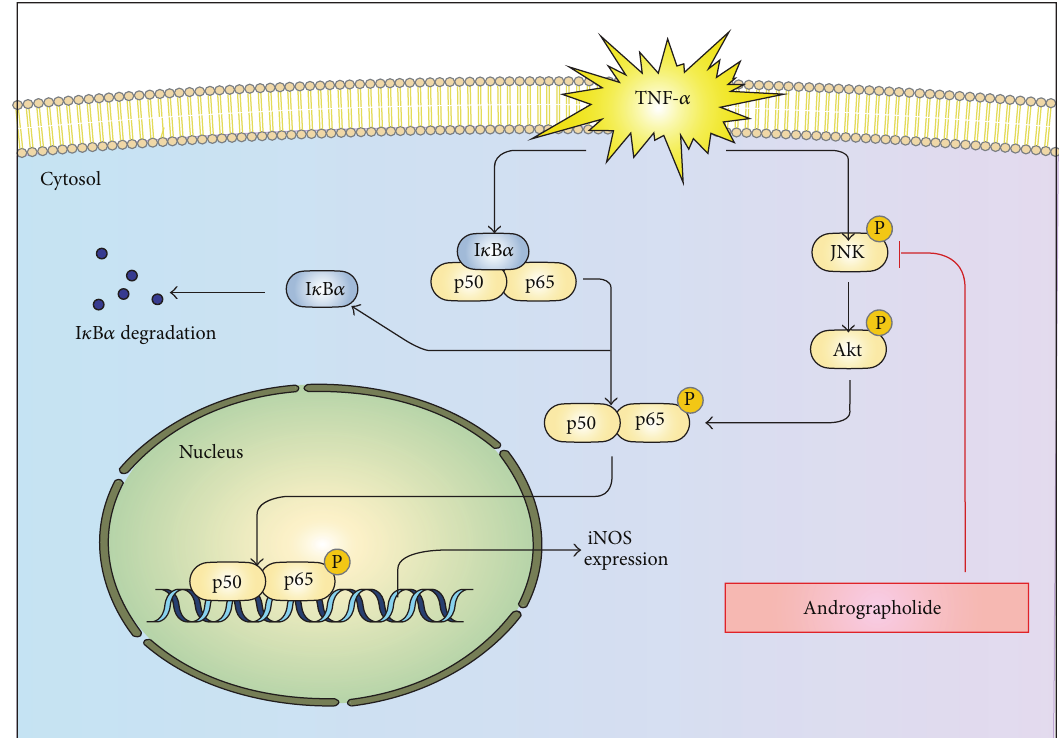
Figure 6: Diagram of the hypothetical inhibitory mechanism of andrographolide-induced effects in TNF- 𝛼 -stimulated VSMCs. TNF- 𝛼 triggers the expression of iNOS through I 𝜅 B 𝛼 -(I 𝜅 B 𝛼 -p65) and I 𝜅 B 𝛼 -independent (JNK-Akt-p65) pathways.